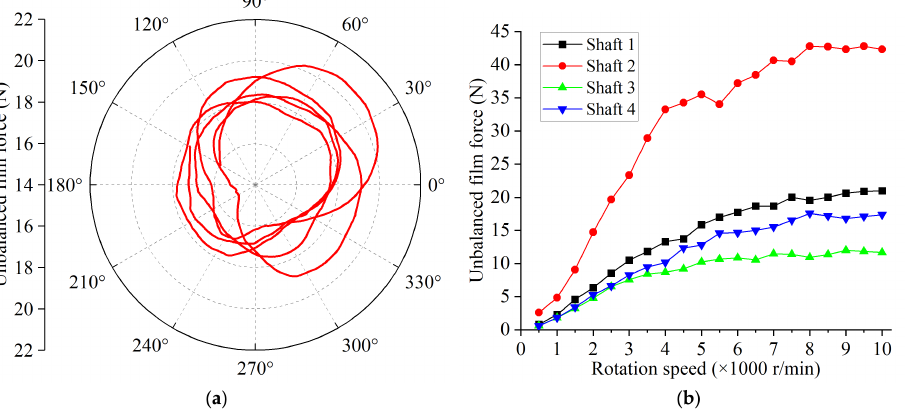
Figure 8. Gas film force of shaft: ( a ) gas film force of shaft 1 (5 revolutions) at 6000 r/min; ( b ) gas film force of shafts in different